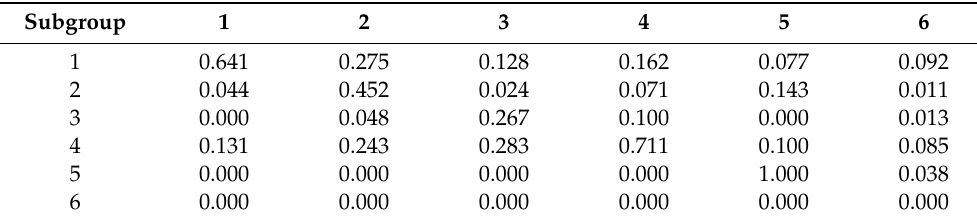
Table 3. Density matrix of cohesive subgroups at the county level in Zhejiang Province. Subgroup